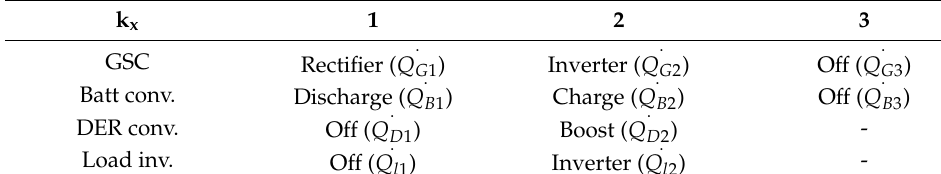
Table 5. k values, corresponding functions, and state space representation